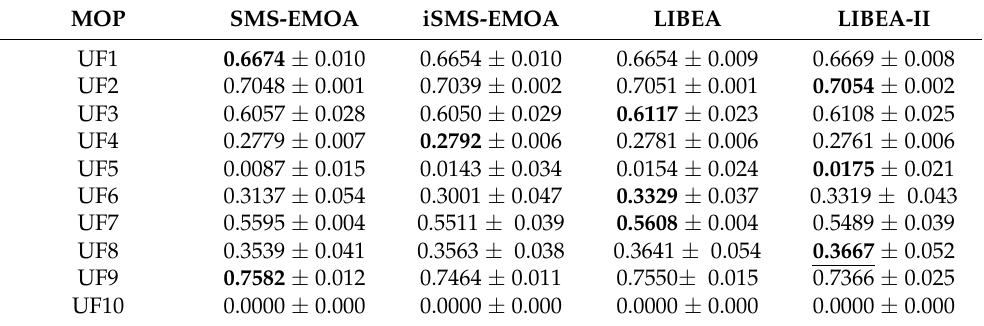
Table 3. Average H n values for the non-dominated solutions found by the IBEAs to each UF test problem.